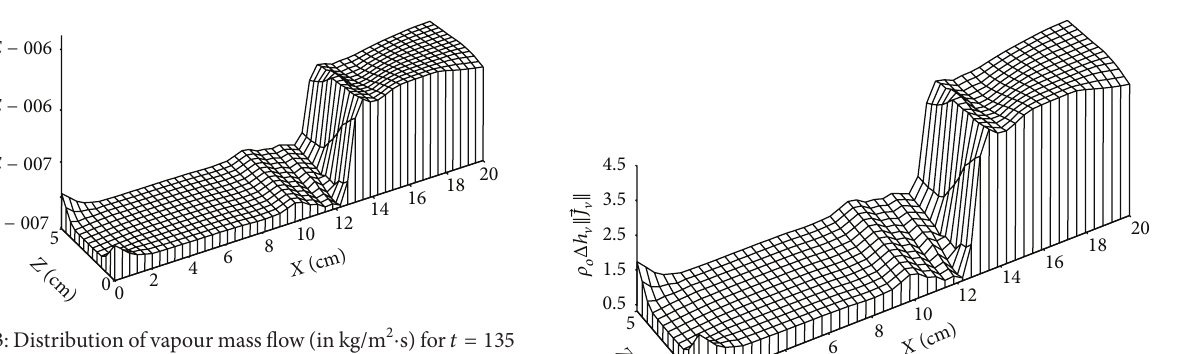
Figure 13: Distribution of vapour mass flow (in kg/m 2 ⋅ s) for 𝑡 = 135 days.